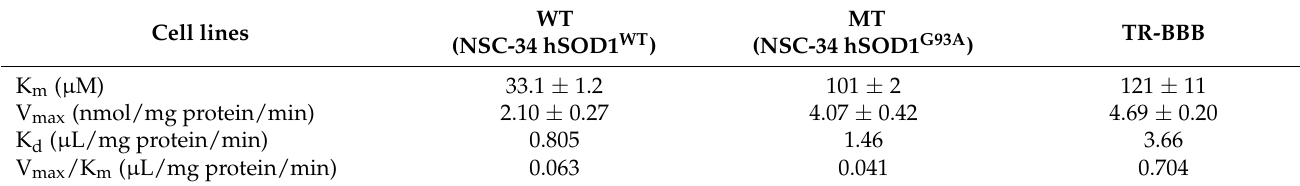
Table 1. Kinetic parameters of [ 3 H] L -tryptophan uptake by TR-BBB and NSC-34 cell lines. Cell